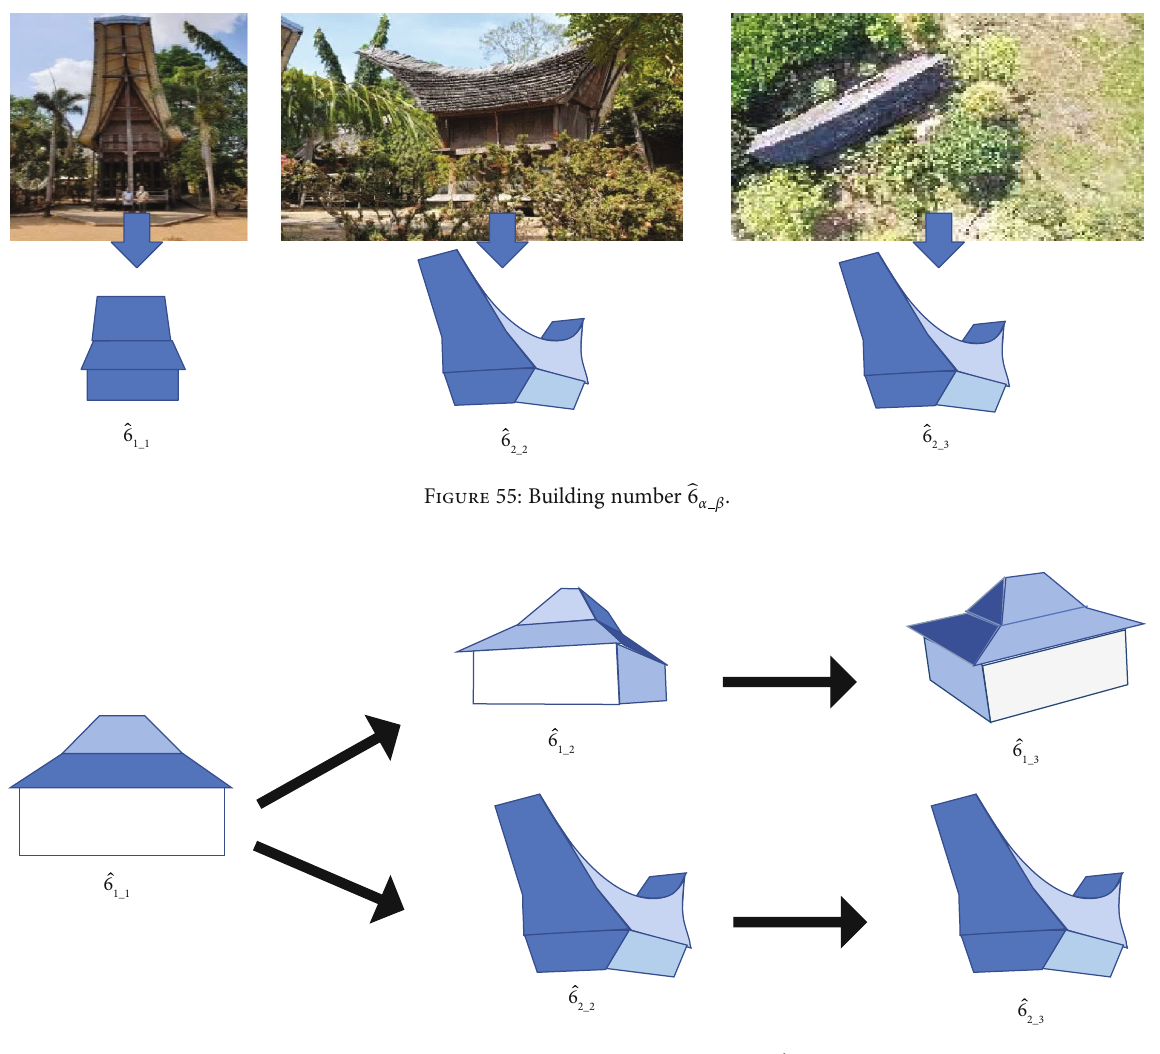
Figure 56: The construction of building number b 6